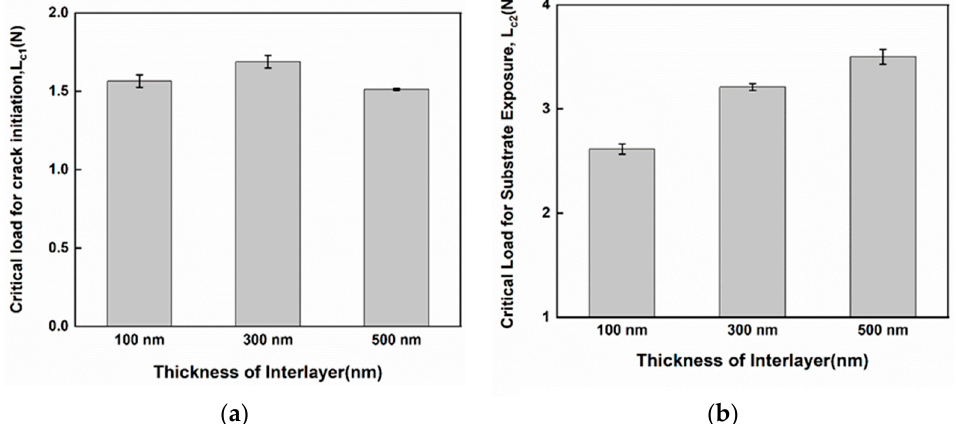
Figure 7. Comparison of ( a ) critical load for crack initiation in coating, L c 1 and ( b ) critical load for coating failure, L c 2 due to the variation of interlayer thickness within the bi-multilayer